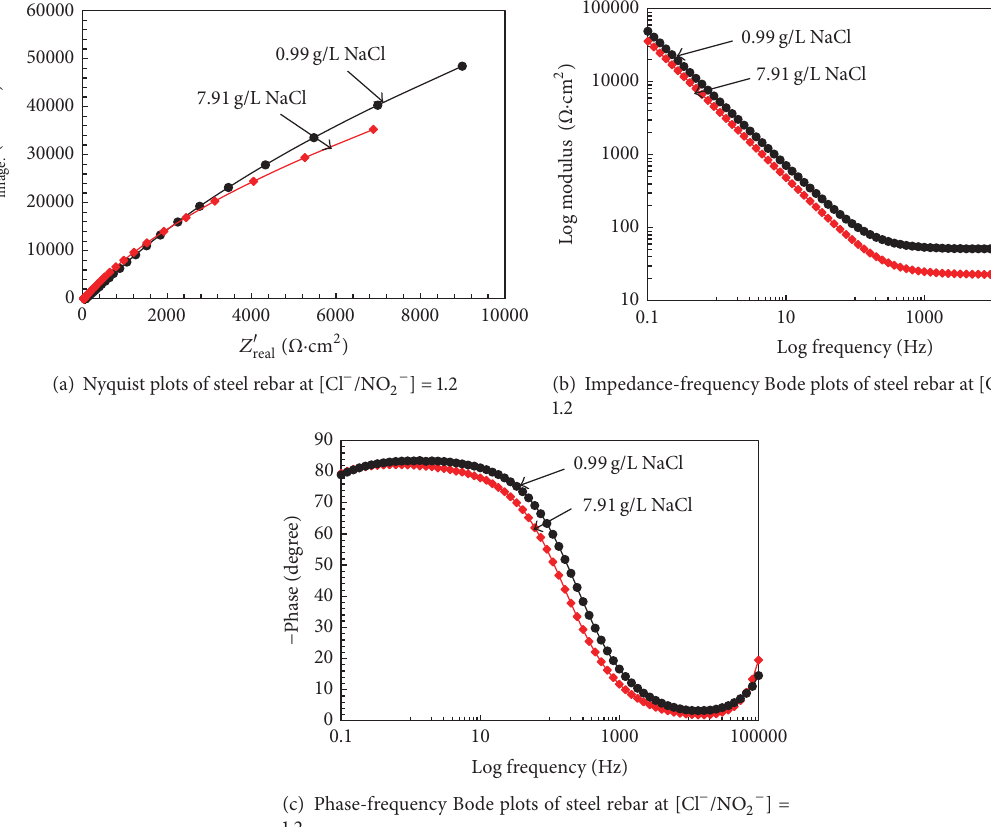
(c) Phase-frequency Bode plots of steel rebar at [Cl − / NO 2− ] = 1.2